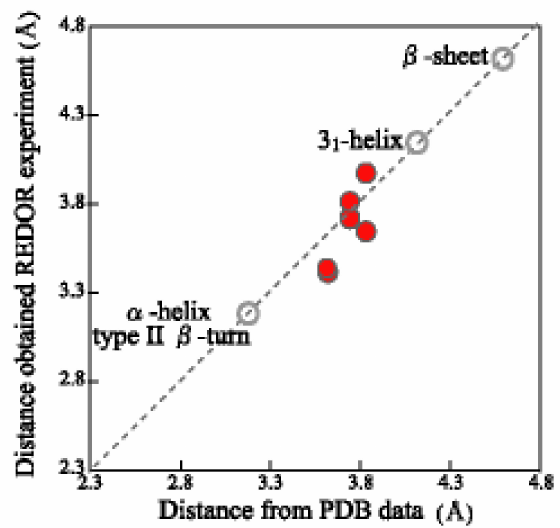
Figure 4. Plot of the REDOR-determined inter-nuclear distances of the 13 C– 15 N nuclei in Table 1(I) vs. the corresponding distances calculated from the PDB database. The red circles indicate the inter-nuclear distances between [1- 13 C]Gly and [ 15 N]Gly nuclei in the [1- 13 C]Gly-X-[ 15 N]Gly (X = Q,Y,L, and R) motifs determined by REDOR experiment in Table 1(I) and those calculated from the PDB database. The grey hollow circles are corresponding distances of typical conformations: anti-parallel β